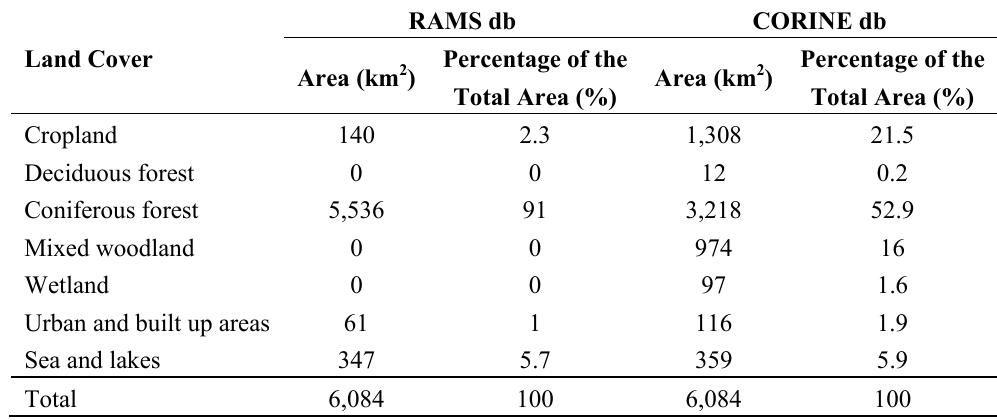
Table 1. Land-cover distribution in the studied region according to RAMS and CORINE. RAMS db Land Cover Area (km 2